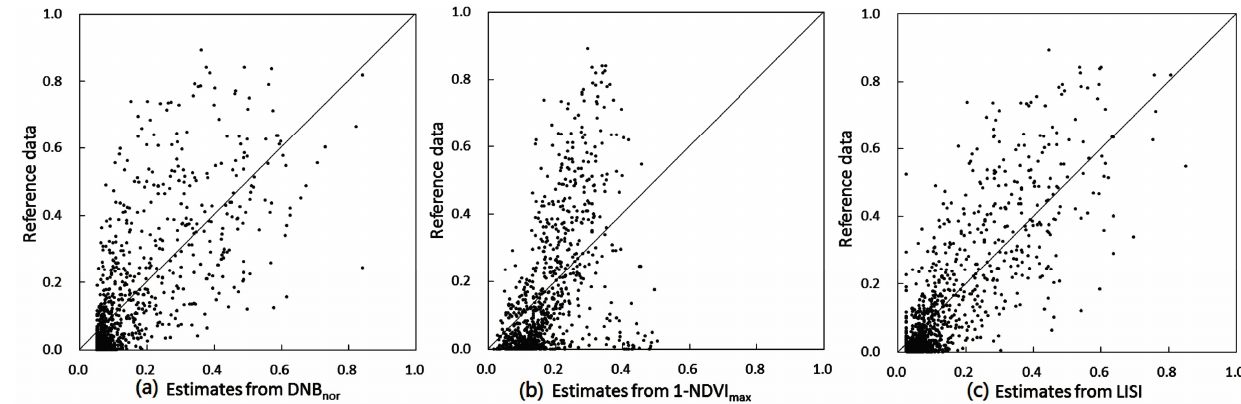
Figure 8. The relationships between ISA estimates and corresponding reference data among three datasets; ( a ) ISA estimates from DNB nor ; ( b ) ISA estimates from 1-NDVI max ; and ( c ) ISA estimates from LISI.